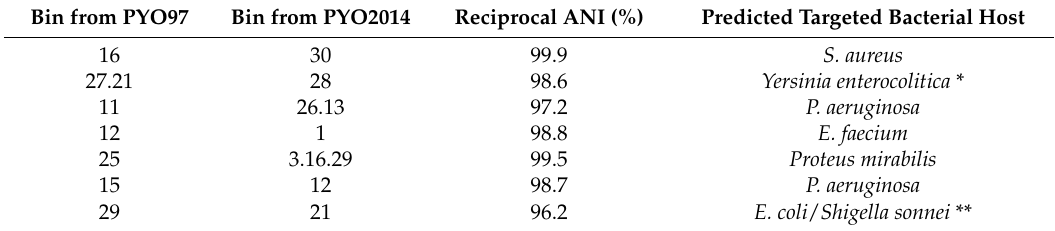
Table 6. Overview of correspondent draft genomes between PYO97 and PYO2014 and the reciprocal ANI. The last column displays the targeted host as predicted by HostPhinder. Bins 10_85..., and 27_42... in the table correspond to bin